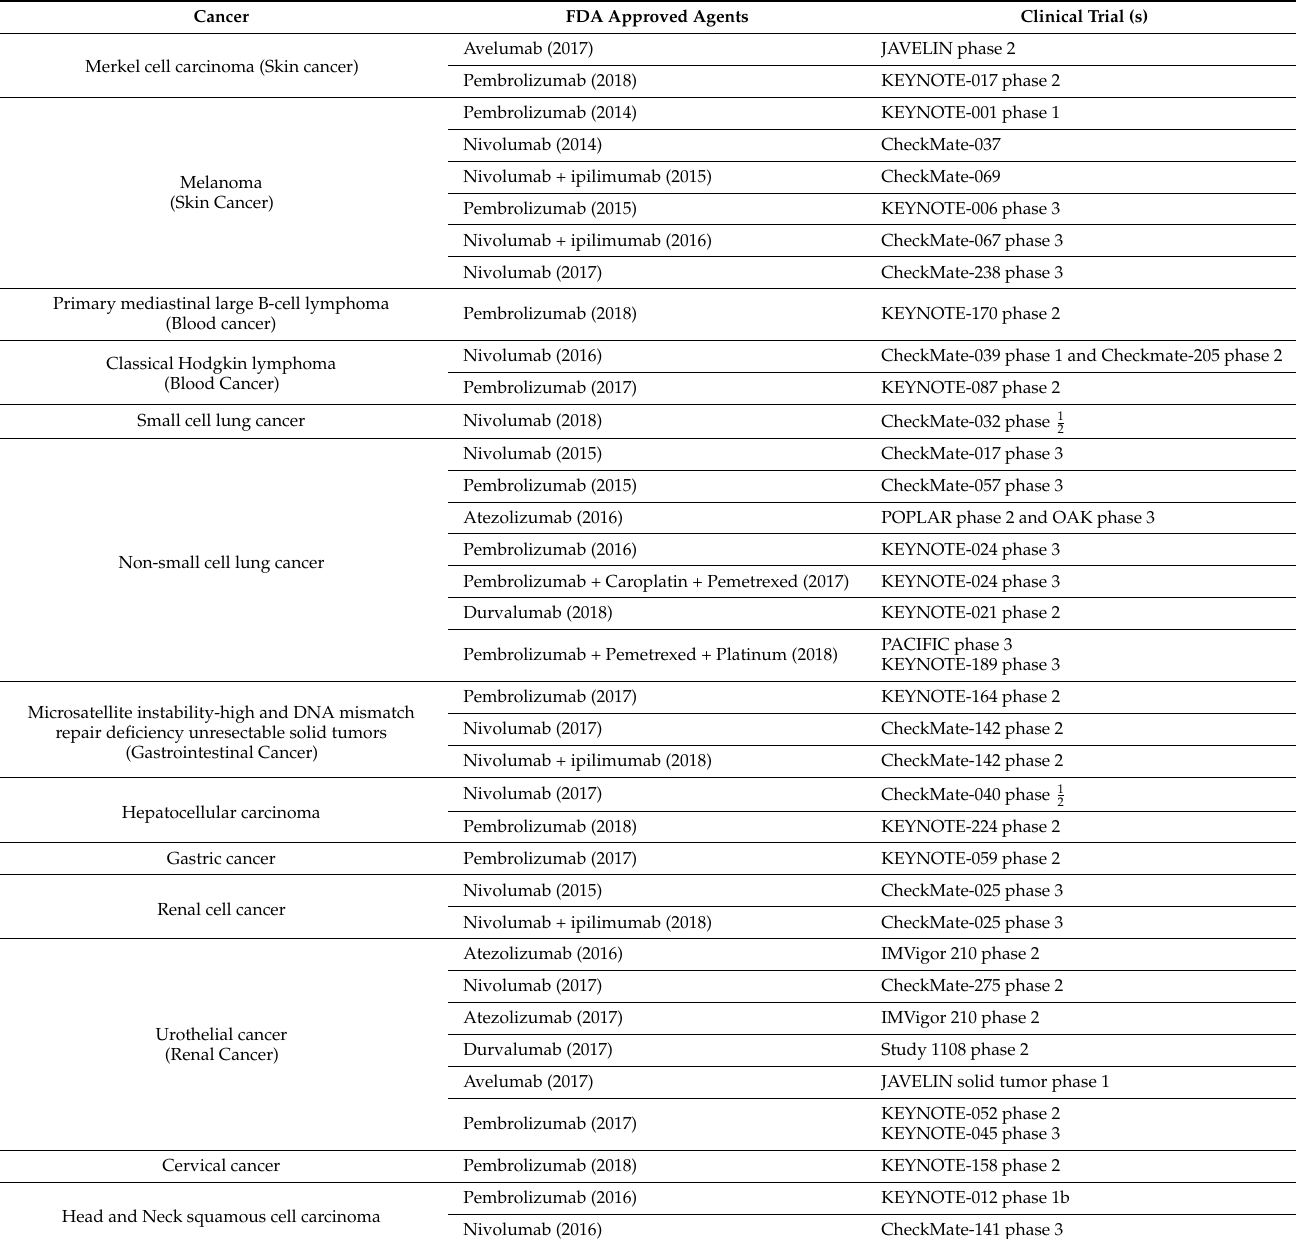
Table 1. List of PD-L1/PD-1 blockade approved therapies in different types of